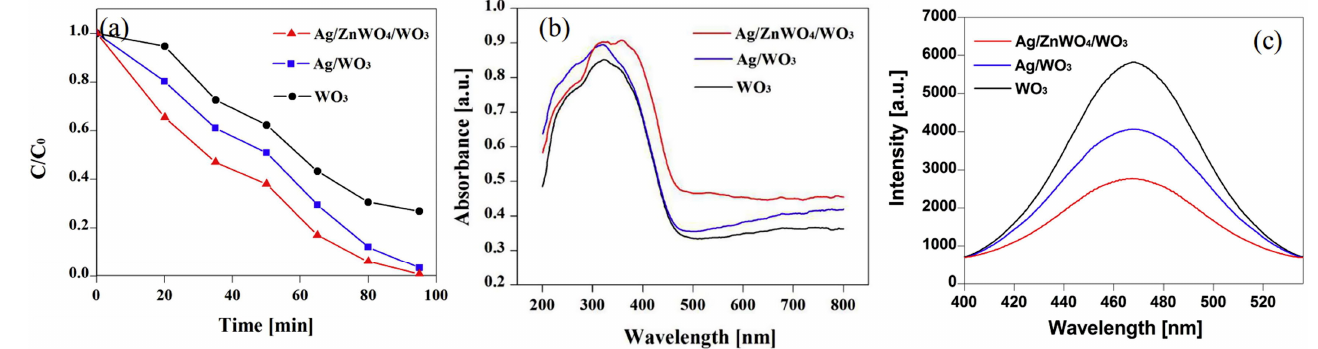
Figure 1. ( a ) Photocatalytic decomposition of methylene blue with WO 3 , Ag/WO 3 , and Ag/ZnWO 4 /WO 3 composites nano fi bers, ( b ) UV/Vis di ff use re fl ectance spectra, and ( c )